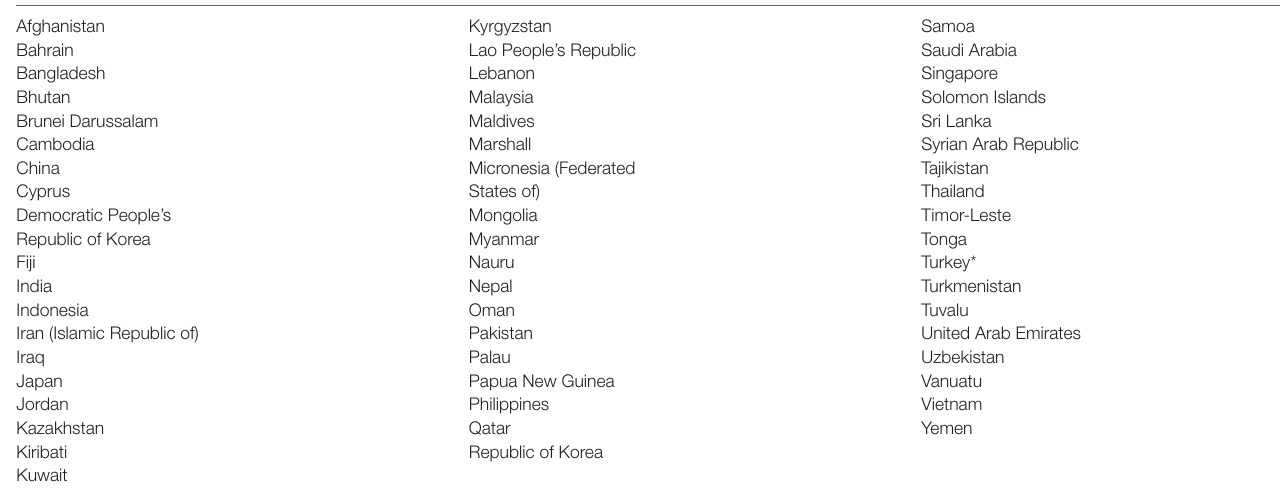
TABLE A1 | Asia-Pacific group of the UN regional groups.